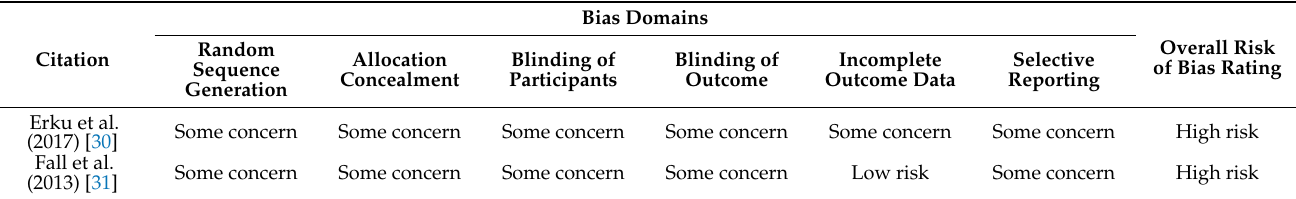
Table 2. Risk of bias in randomized controlled trials (Cochrane Risk of Bias Version 2).